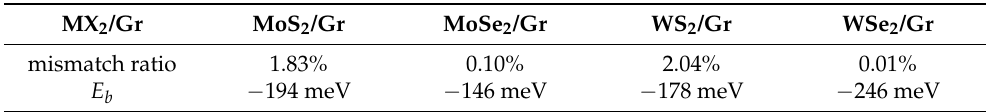
Table 1. The lattice mismatch ratios and the biding energies of TMDCs/graphene with 3 × 3 supercell of MX 2 and 4 × 4 supercell of graphene.